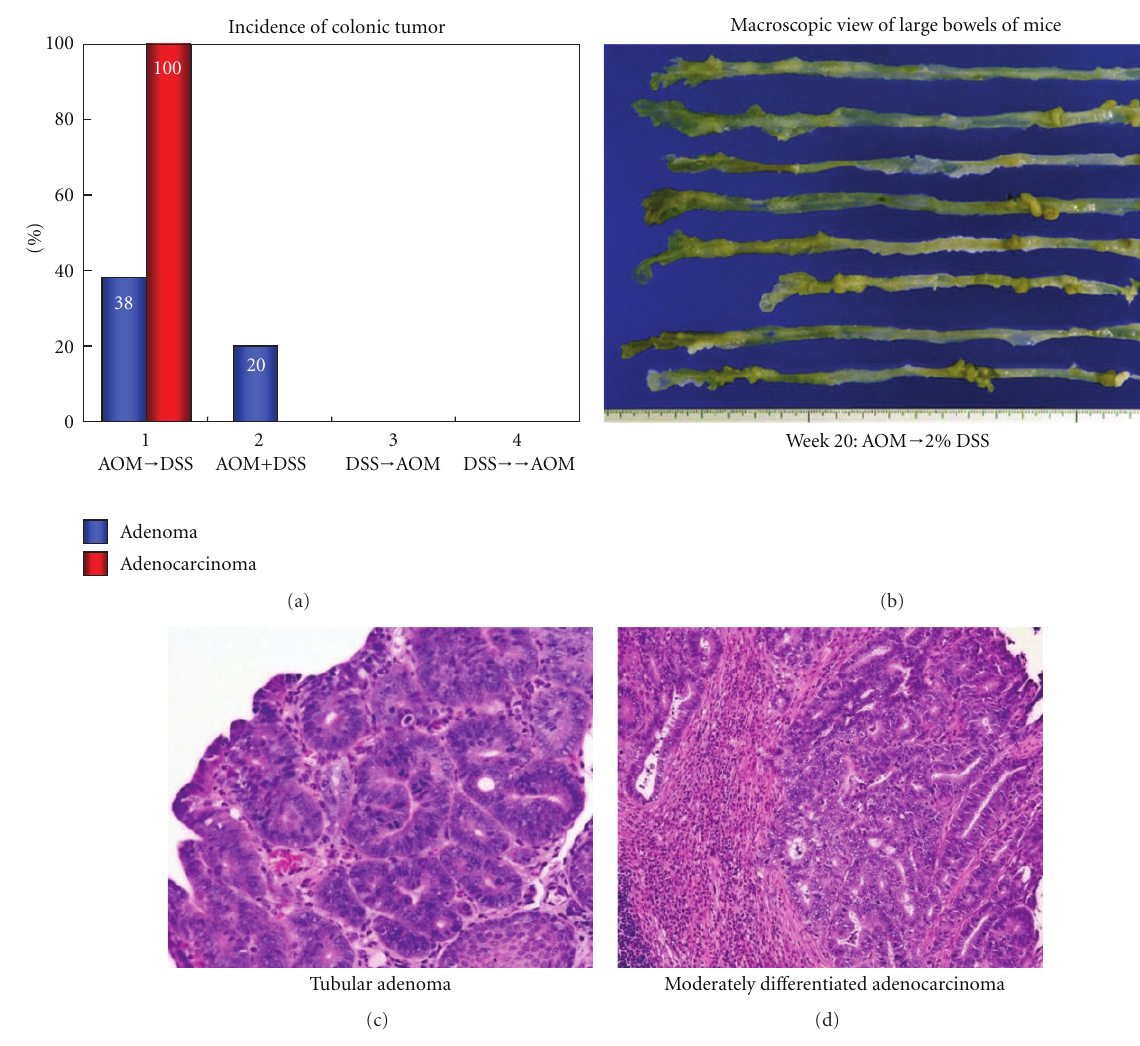
Figure 6: Macroscopic view, incidence, and histopathology of colonic tumors in the groups of mice that received four di ff erent treatment schedules of AOM and